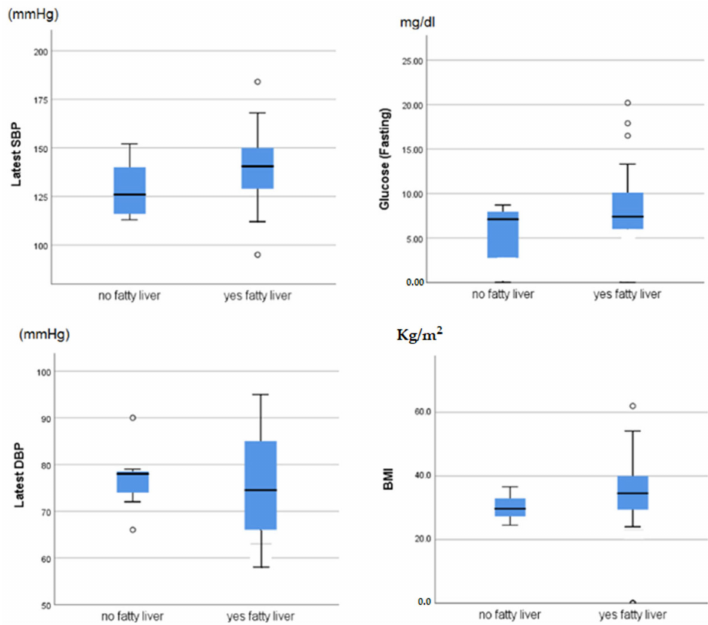
Figure 1. Association between fatty liver and parameters linked to metabolic